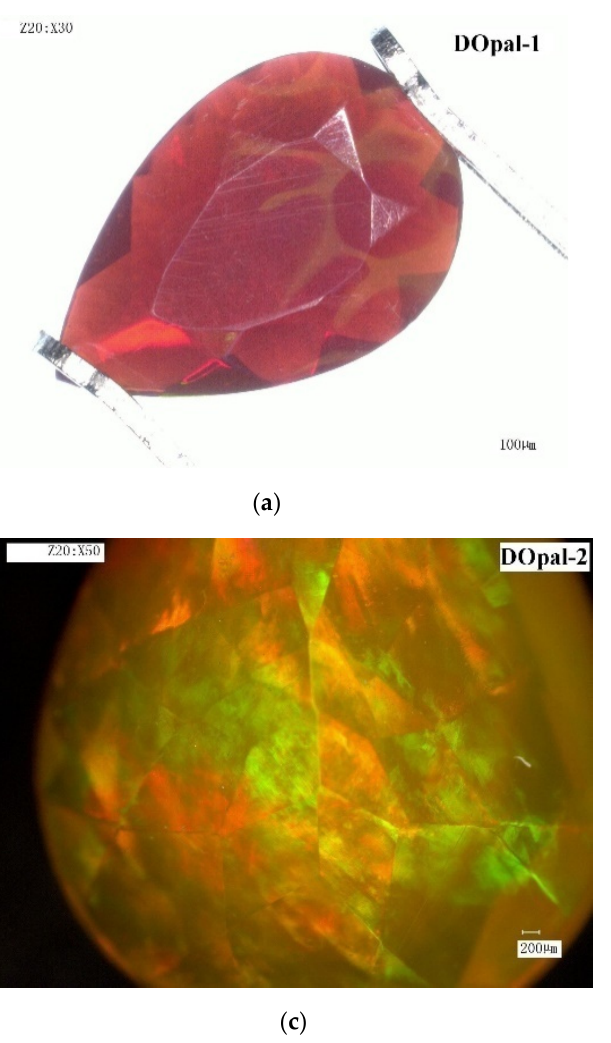
Figure 4. Digital micrographs of sample DOpal-1 and DOpal-2. ( a ) An irregular color distribution; ( b ) A distinct color concentration along the edge of the stone; ( c , d ) Subtle color concentrations and irregular color patches.